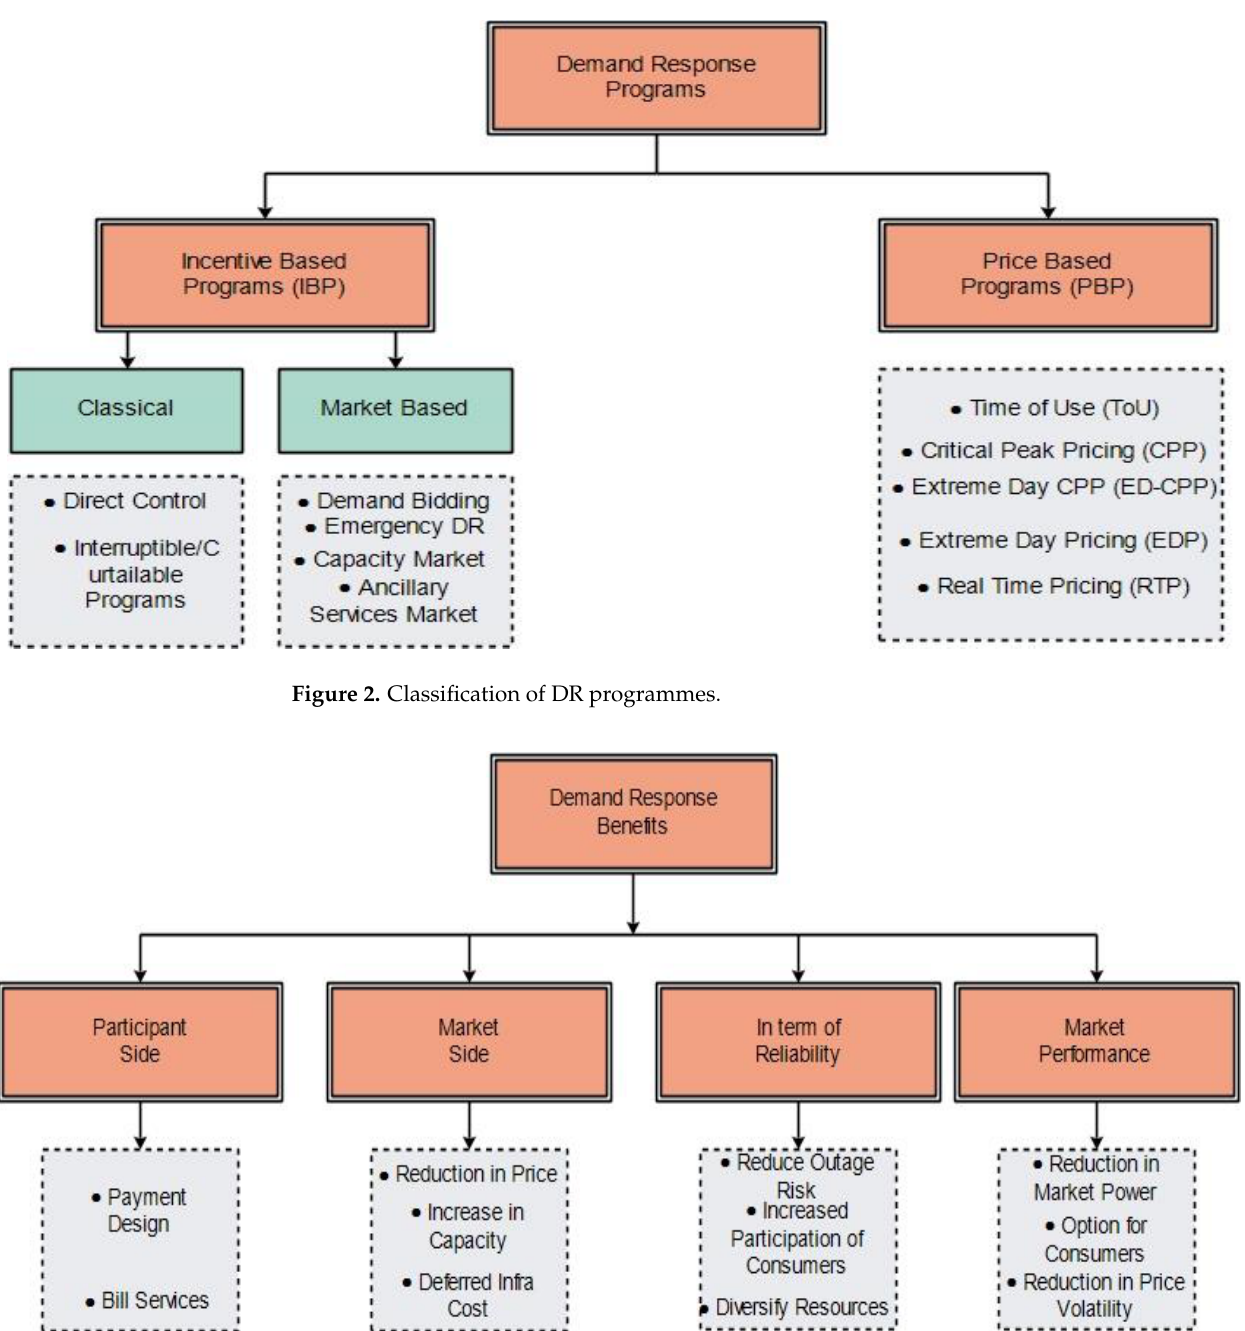
Figure 3. Benefits related to DR.